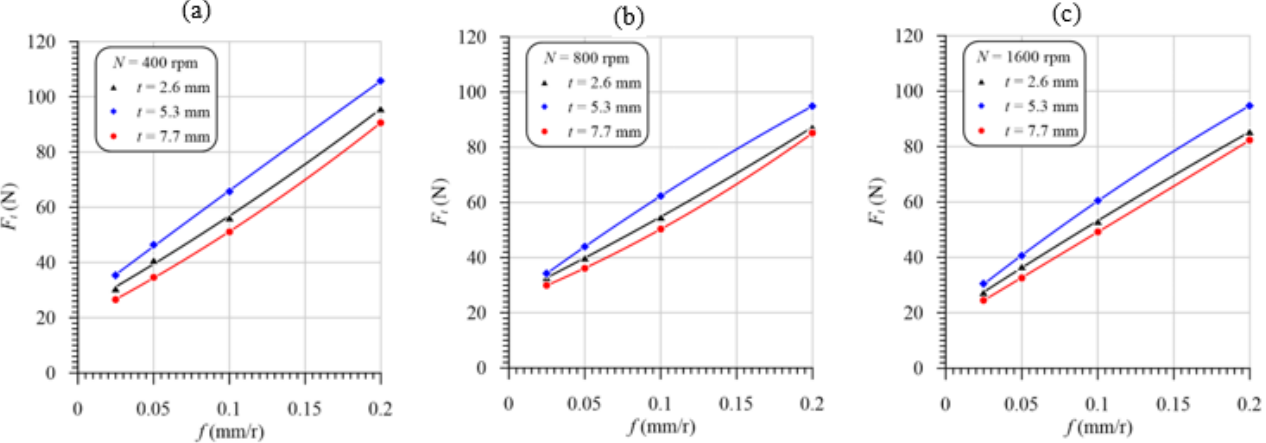
Figure 11. Thrust force vs. feed at different laminate thicknesses and speeds of ( a ) 400 rpm, ( b ) 800 rpm, and ( c ) 1600 rpm.